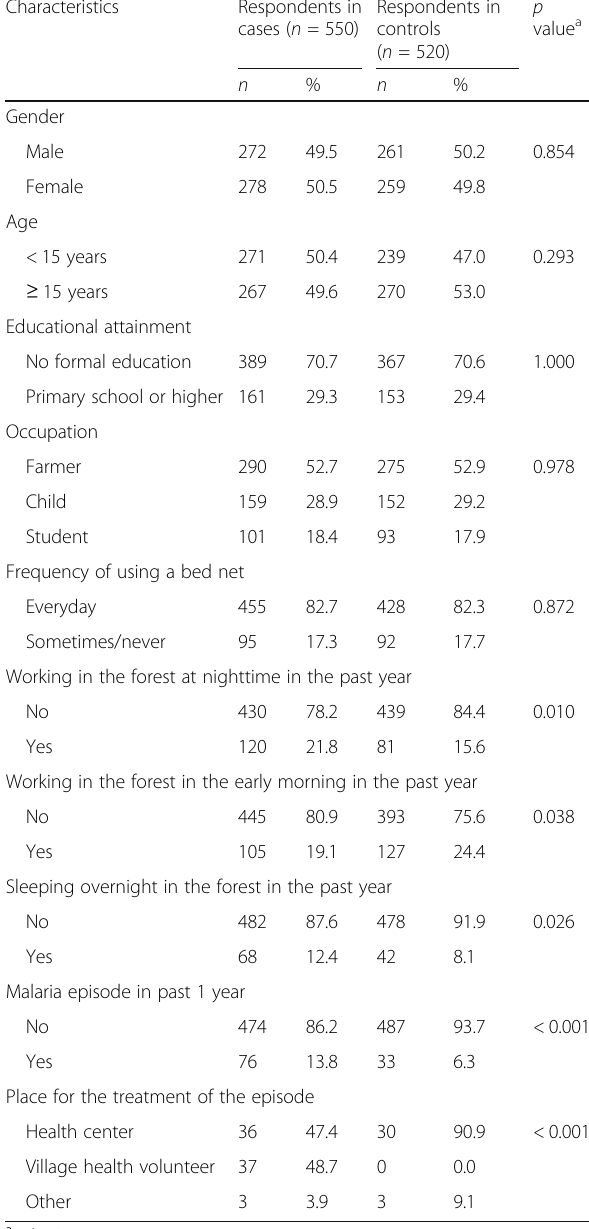
Table 2 Bivariate analysis of differences in individual-level characteristics